Question: In one sentence, what is this figure communicating?
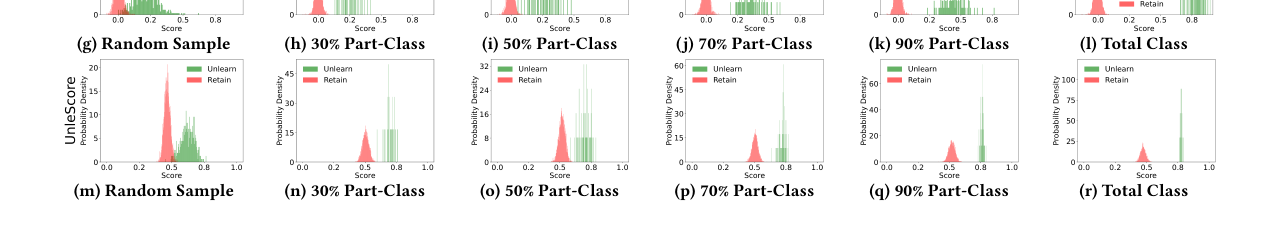
Answer: Score Distributions of Unlearning Metrics with Different Unlearning Tasks on Location.